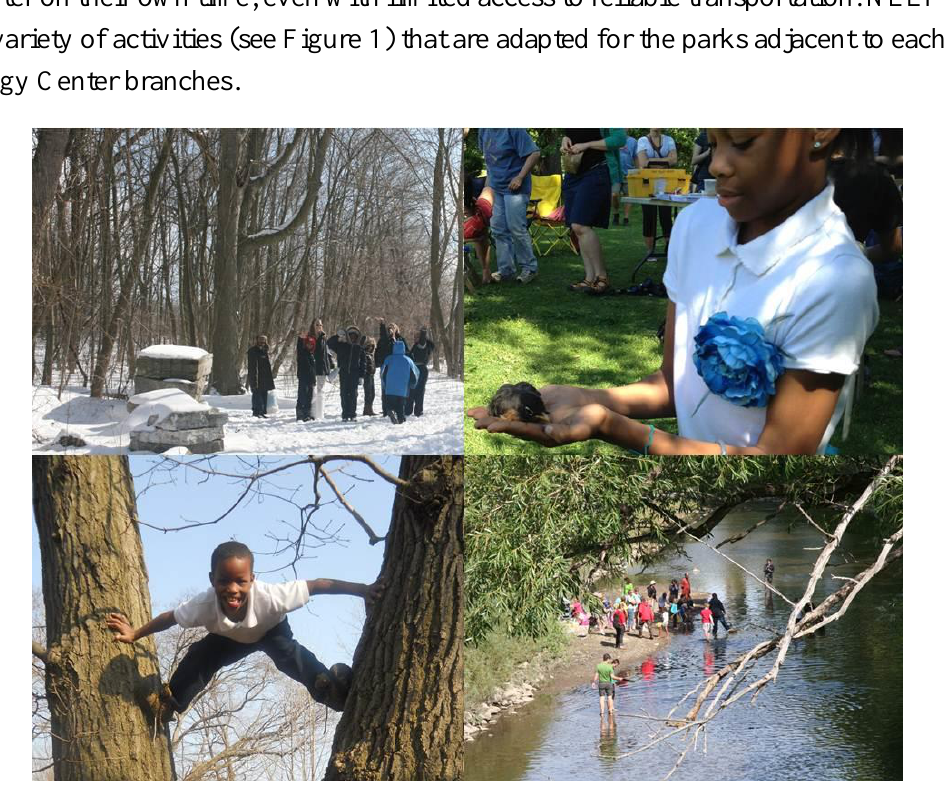
Figure 1. Children engaged in NEEP programming (pictured are not study